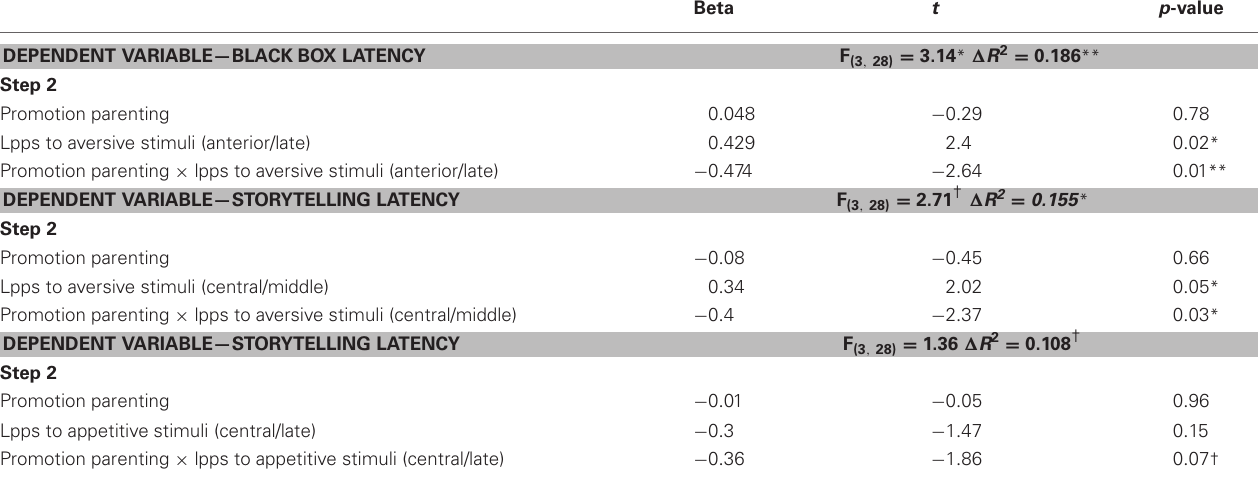
FIGURE 6 | LPPs to appetitive stimuli interact with promotion parenting to predict inhibited behavior during the storytelling task. Note : Longer latencies indicate more inhibited behavior. LPPs are quantified as the difference between LPP amplitudes to appetitive minus LPPs to neutral Table 2 | Standardized regression coefficients for interaction